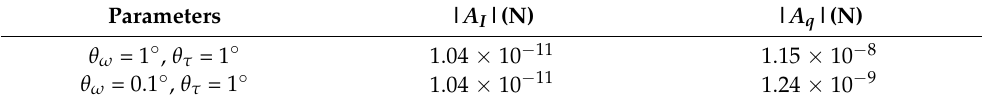
Table 1. Theoretical calculation of the amplitude of the quadrature and in-phase coupling force.